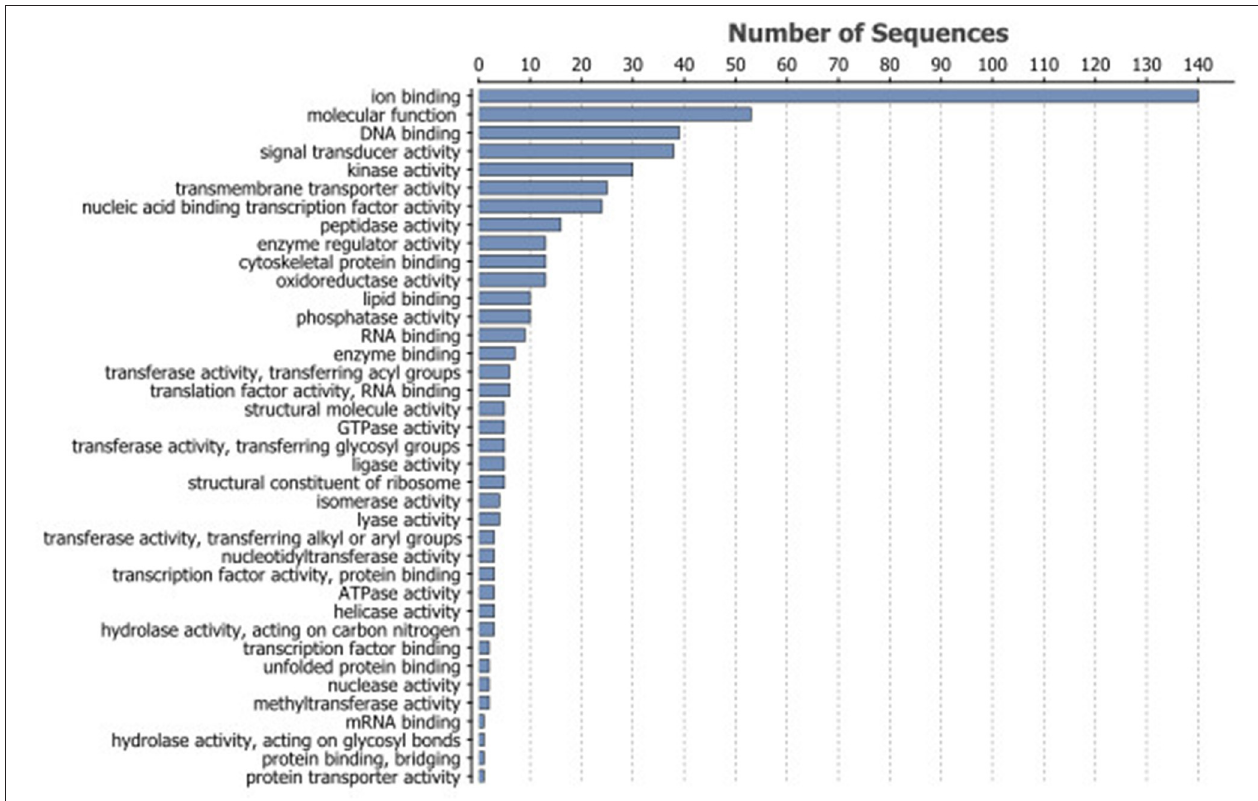
FIGURE 4 | Most frequent GO terms associated with the 742 DEGs with lower transcript levels in old erythrocytes.